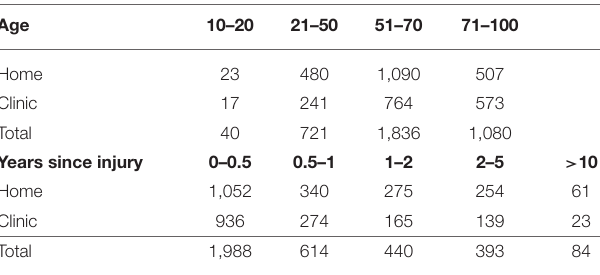
TABLE 2 | Count of PWA included in each task by home and clinic therapy